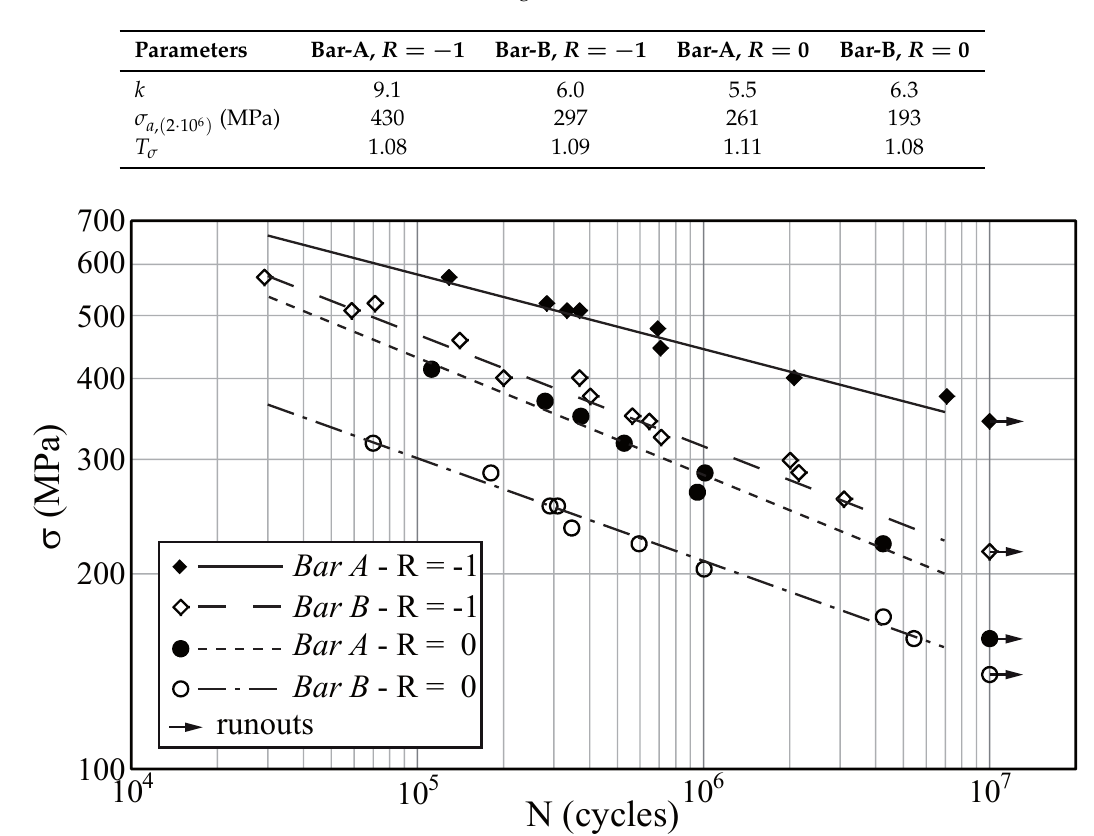
Table 5. Fatigue statistical data.